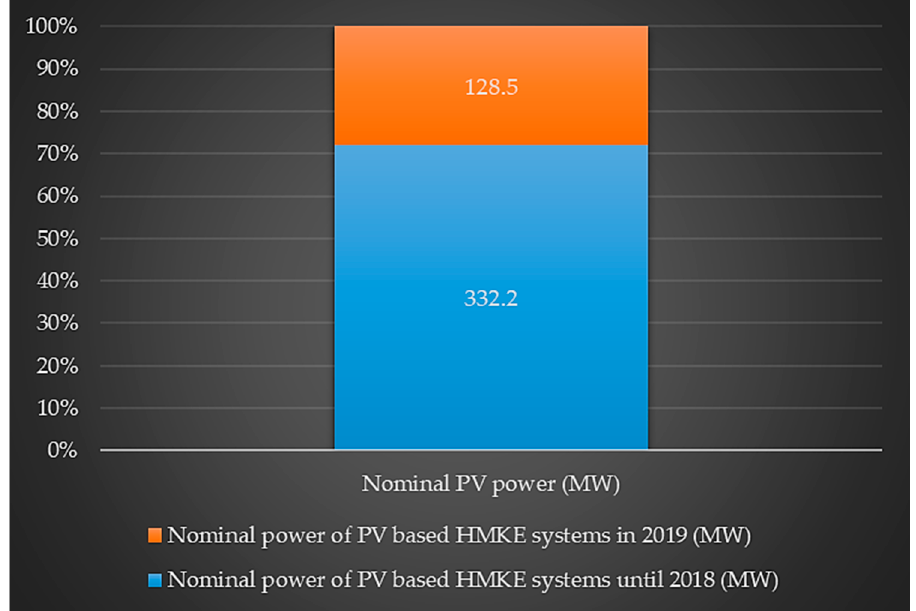
Figure 2. The nominal power of the PV HMKE systems in Hungary [27].